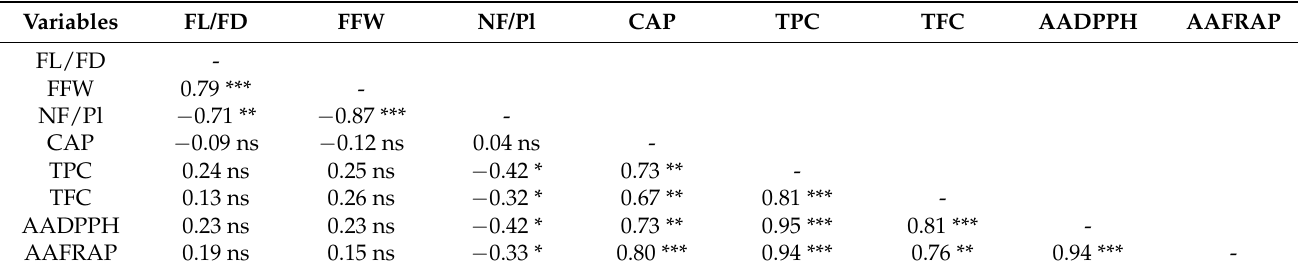
***, ** and * indicate significance at p ≤ 0.001, p ≤ 0.01 and p ≤ 0.05, and ns indicates non-significance. FL/FD: ratio fruit length (FL, expressed as cm)/fruit diameter (FD, expressed as cm); FFW: fruit fresh weight; NF/Pl: number of fruits per plant; CAP: capsaicin content; TPC: total phenol content; AAFRAP: antioxidant activity (AA) determined by FRAP assays; AADPPH antioxidant activity (AA) determined by